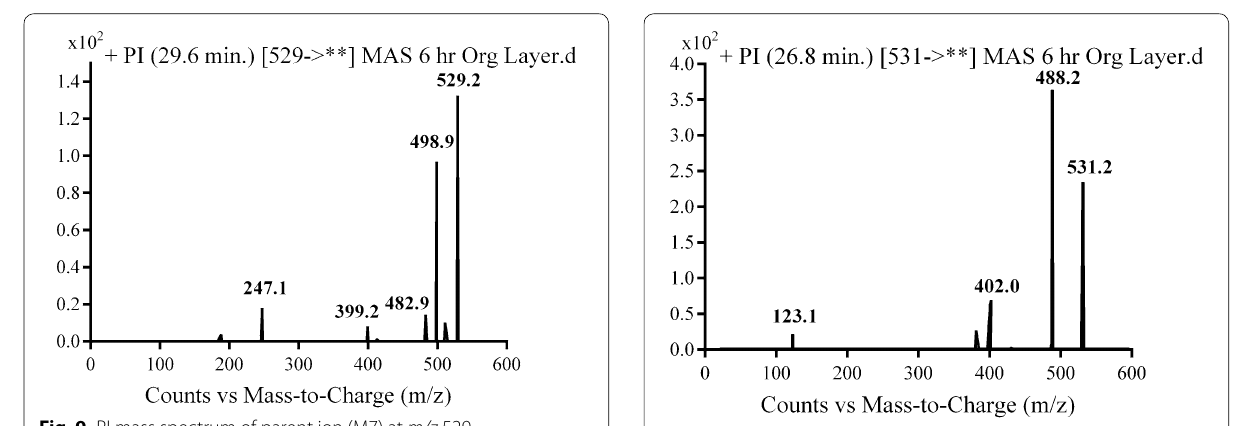
Fig. 10 PI mass spectrum of parent ion (M8) at m/z